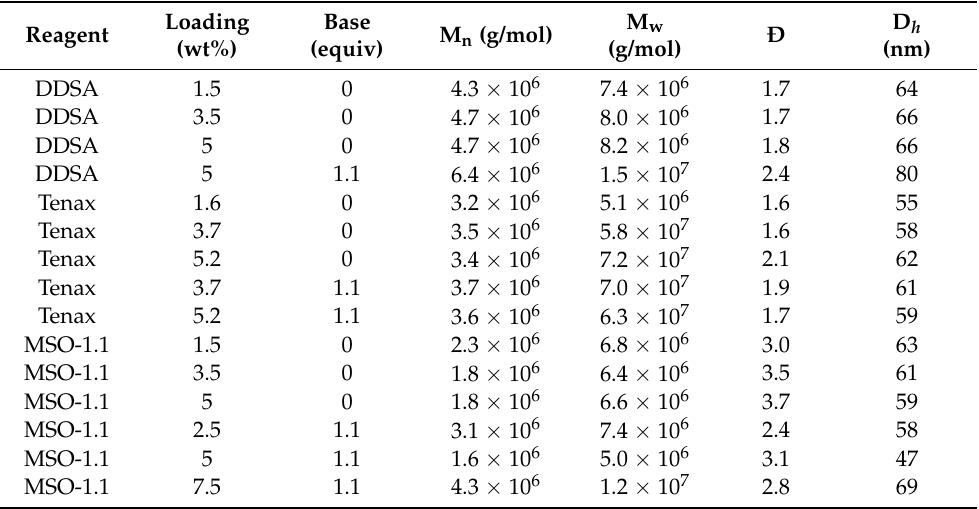
Table 7. Absolute molecular weight averages and D h for starch modified with DDSA, TENAX, and maleated soybean oil by reactive